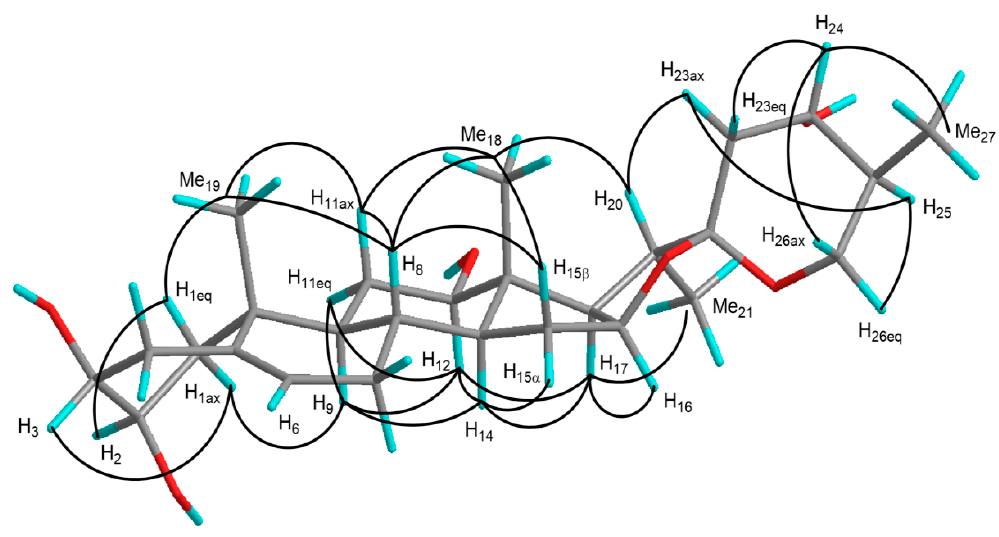
Figure 3. NOE correlations of 1a .